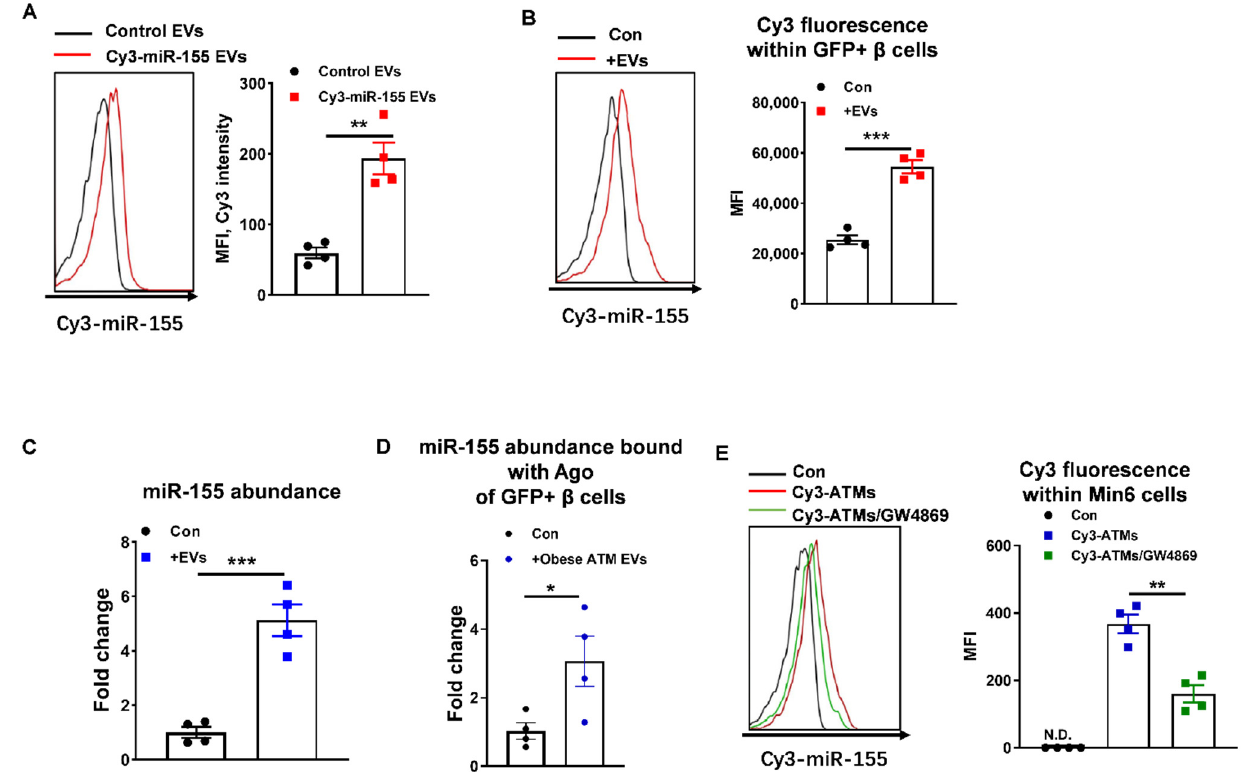
Figure 1. Obese adipose tissue macrophages (ATMs) secrete extracellular vesicles (EVs) as cargos delivering miRNAs into β Cells. ( A ) The delivery of Cy3-miR-155 mimics into EVs derived from obese ATMs transfected with Cy3-miR-155 mimics by flow cytometric analysis. ( B ) Cy3 red fluorescent intensity within GFP+ β cells after MIPGFP islets co-cultured with Cy3-miR-155 containing obese ATM EVs by flow cytometric analysis. ( C ) miR-155 abundance in islets co-cultured with obese ATM EVs. ( D ) The abundance of miR-155 bound with argonaut (Ago) proteins of GFP+ β cells after treatment of MIPGFP islets with obese ATM EVs. ( E ) Cy3 red fluorescent intensity within Min6 cells co-culutred with Cy3-miR-155 containing obese ATMs in a transwell plate with EV secretion inhibitor GW4869 (10 µM) by flow cytometric analysis. Data are presented as the mean ± SEM. * p < 0.05, ** p < 0.01, *** p < 0.001, Student’s t test ( A – D ) or one-way ANOVA ( E ).